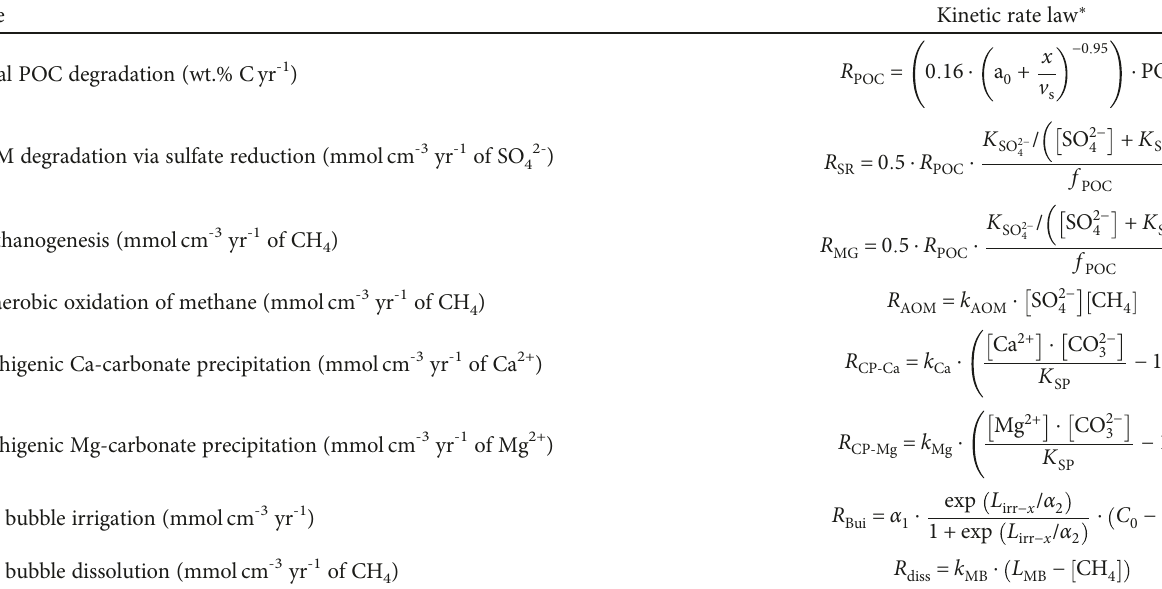
Table 2: Rate expressions of the reactions considered in the